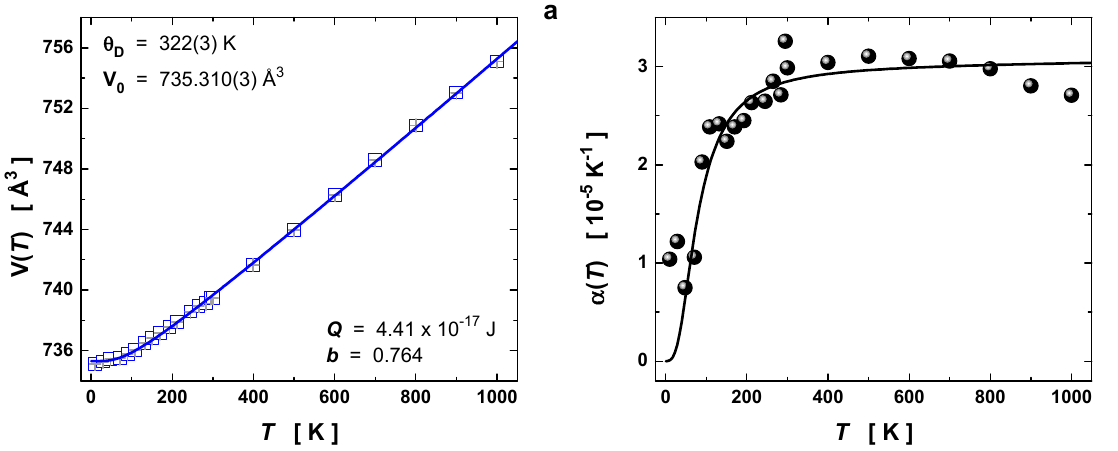
Figure 2. ( a ) Thermal expansion of the unit-cell volume V ( T ) , such that the solid line is the second- order Grüneisen approximation to the zero-pressure equation of state. ( b ) Thermal-expansion coefficient α ( T ) , where the spheres were obtained by numerical first derivative of the unit-cell volume and the black solid line was calculated from the fitted-unit-cell volume expansion using Equation